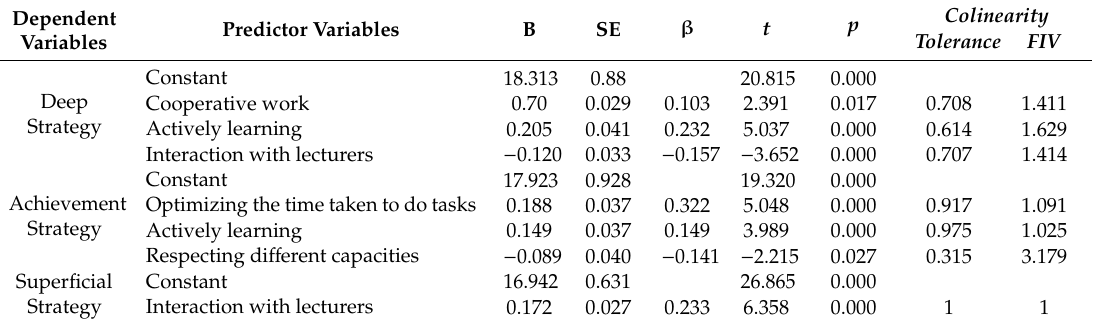
Table 3. Factors associated with learning strategies based on a linear regression